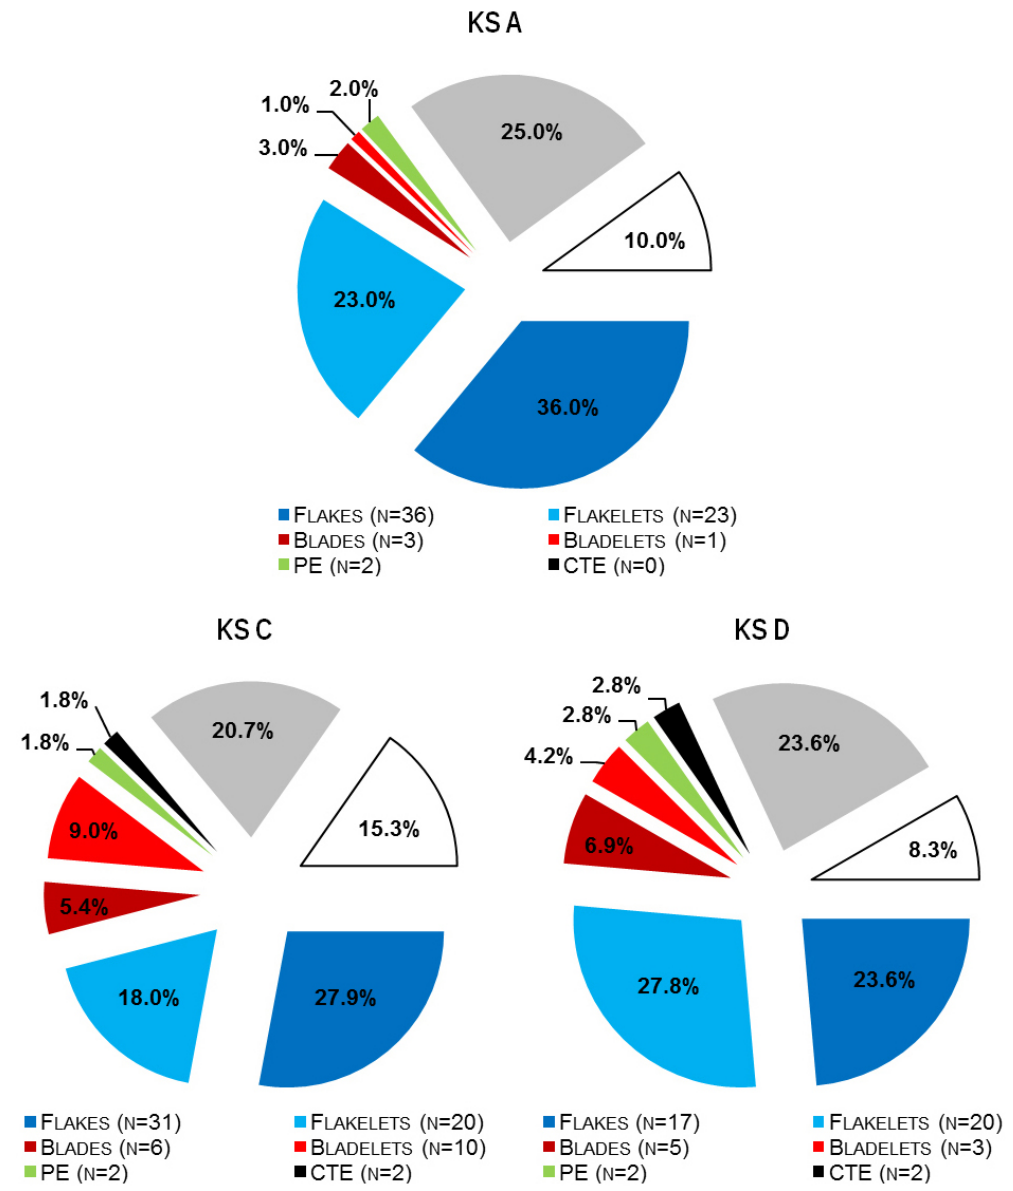
Figure 8. Blank-tool distribution at KS A, KS C and KS